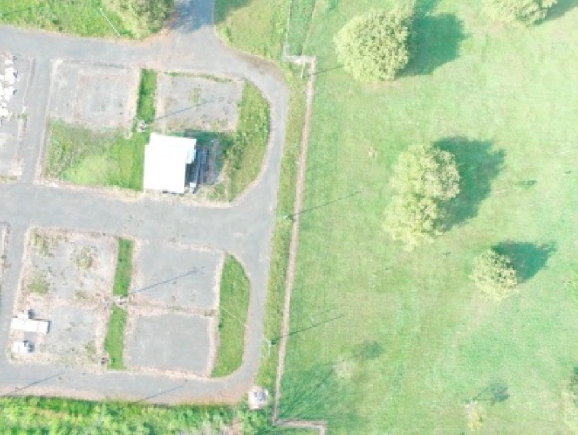
Figure 4. Sample image of Mendeley Thermal and Visible Aerial Imagery.